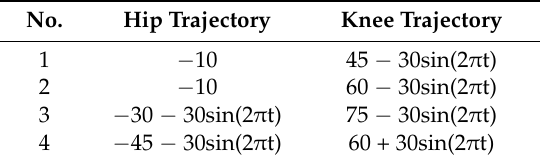
Table 1. Trajectories of hip and knee joints.